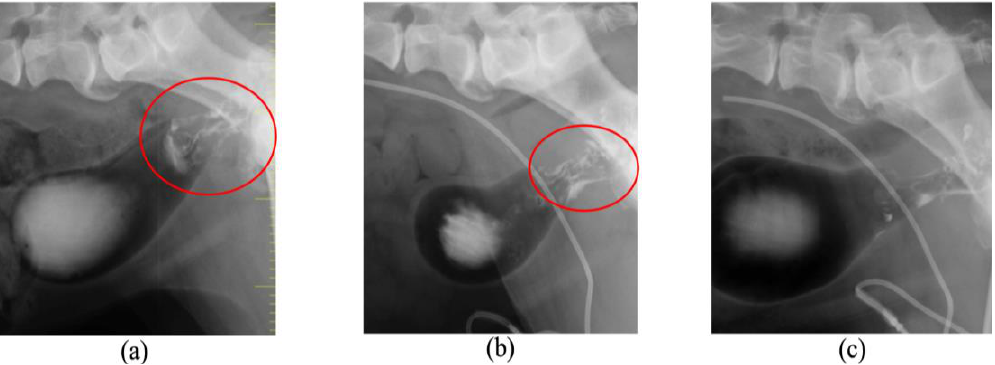
Figure 6. Double contrast images of case No. 11. ( a ) The tumor size of approximately 2 cm in diameter at the trigone of the bladder could be observed on Day 1 (red circle). The tumor slightly decreased in size on Day 56 (red circle) ( b ) and was markedly reduced on day 196 ( c ). The dog survived for 393 days after initial presentation. Table 3. Response of tumors to photodynamic therapy using 5-aminolevulinic acid.